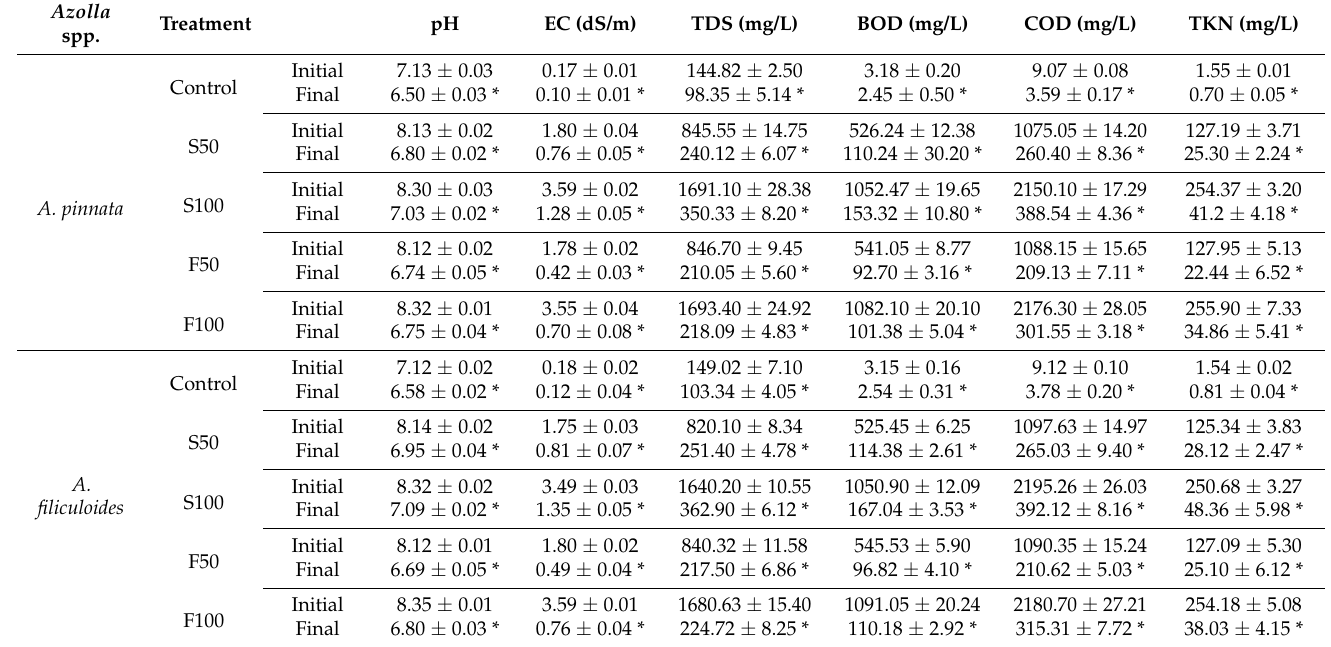
Table 2. Changes in the physicochemical characteristics of MFW before and after cultivation of two Azolla spp.